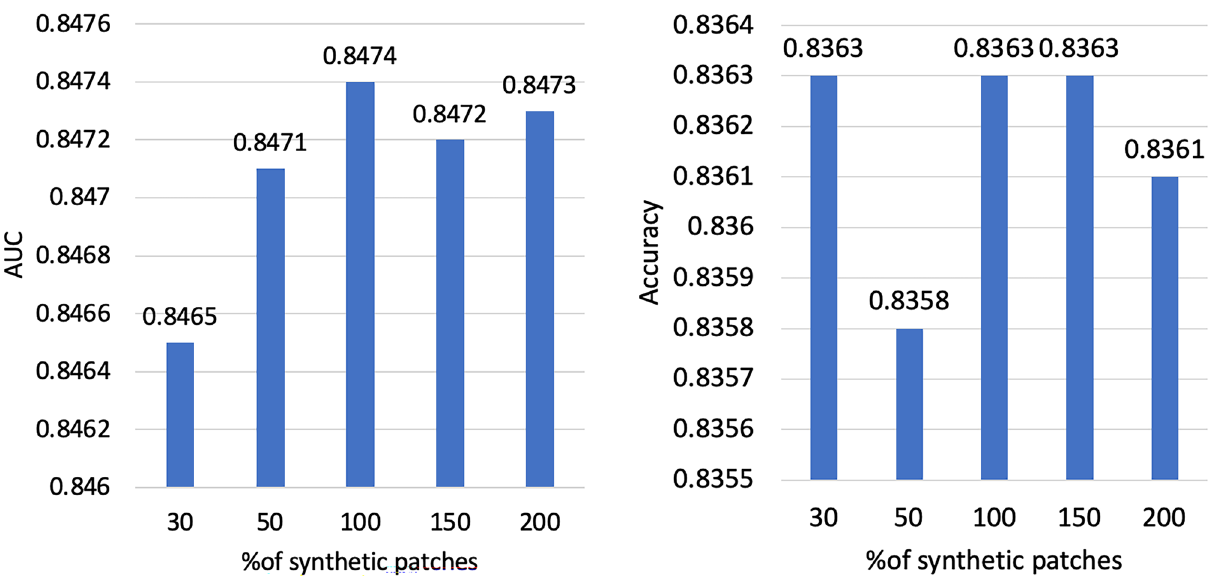
Figure 4. The data labeling performance with varying amounts of additional synthetic